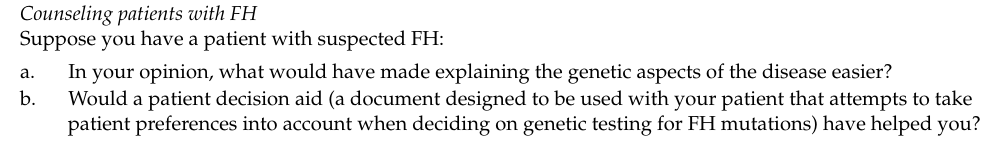
Table 1. Sample questions from focus group discussions with clinicians.